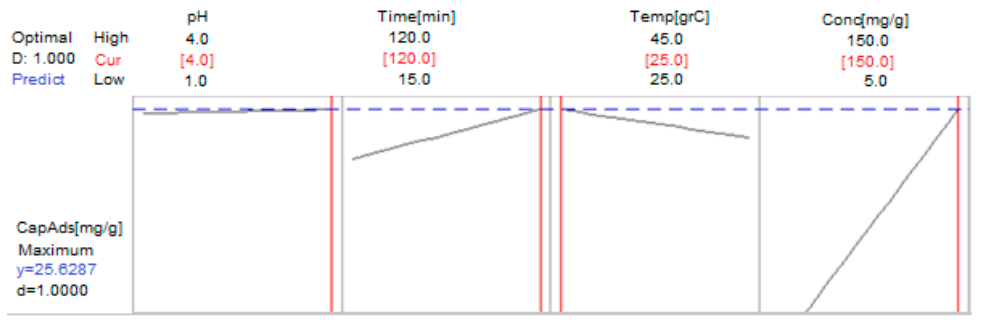
Figure 10. Optimization of the adsorption process of Au (III) on the Am-L-GA material.